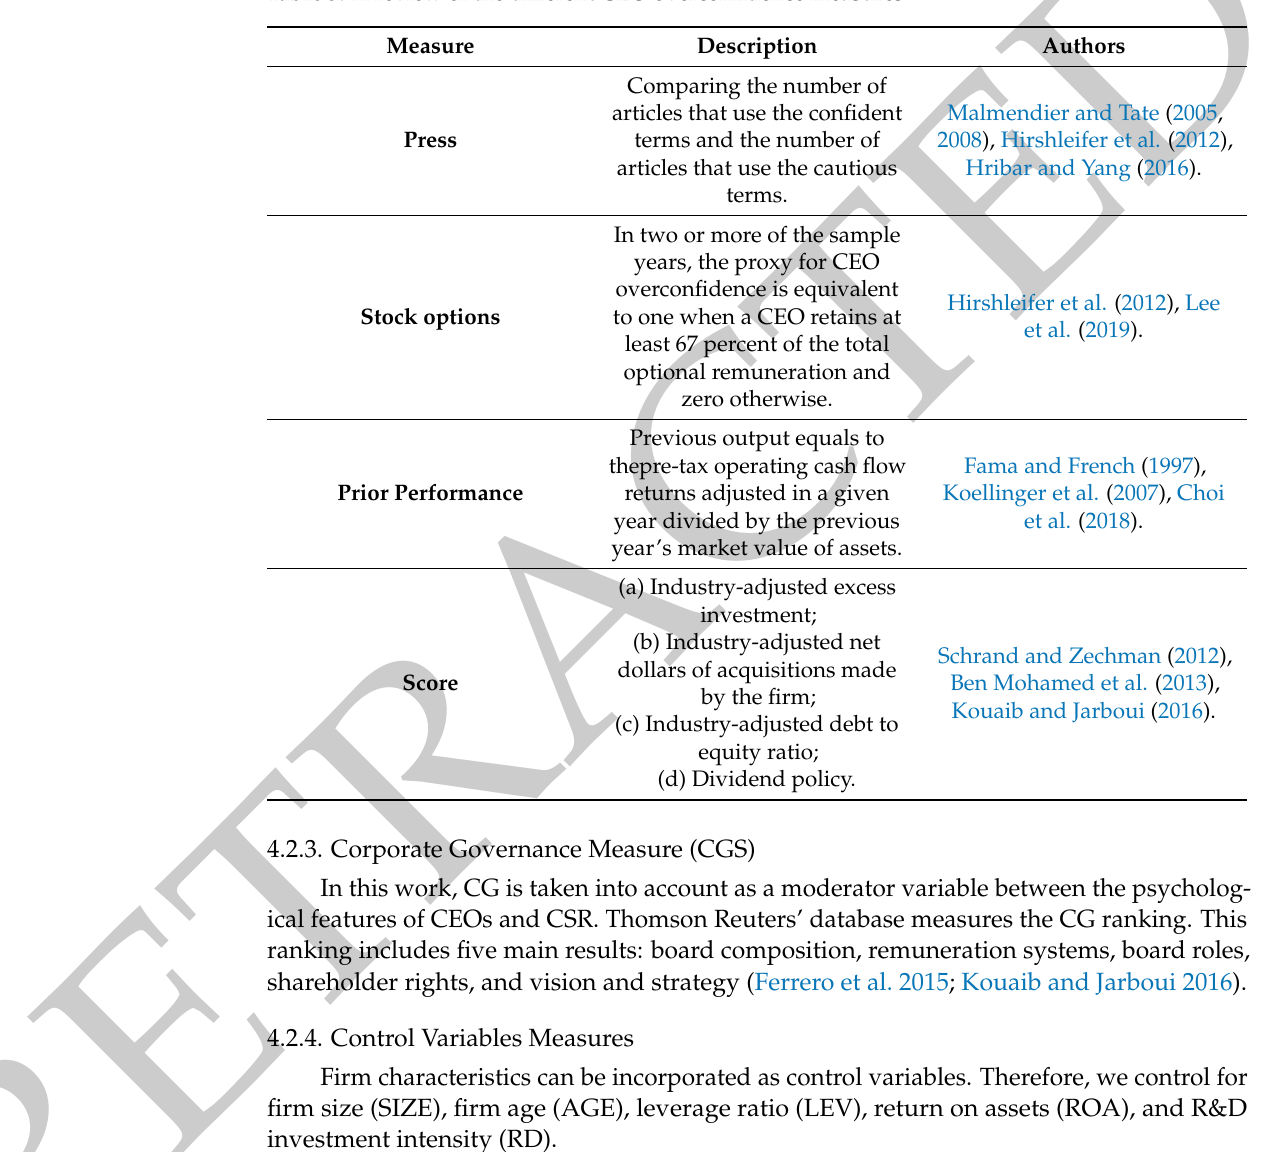
Table 3. A review of the different CEO overconfidence measures. Measure Description